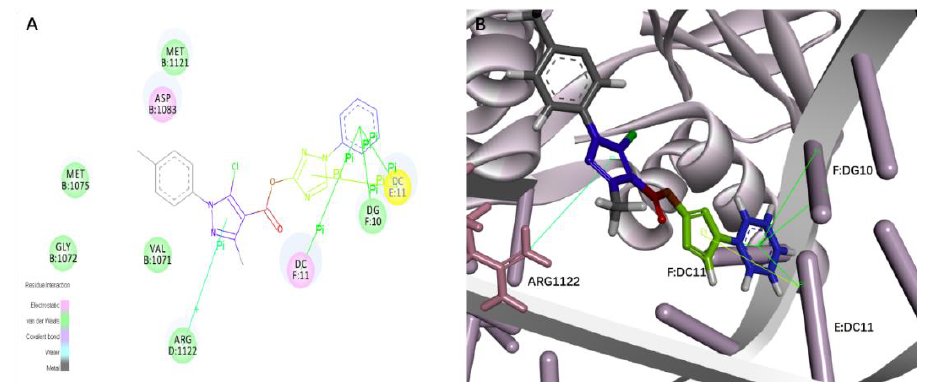
Figure 3. ( A ) Binding model of 4d ( 2D diagram ). ( B ) The π–π interactions are displayed as yellow solid lines. The cation –π interactions are displayed as green solid lines.